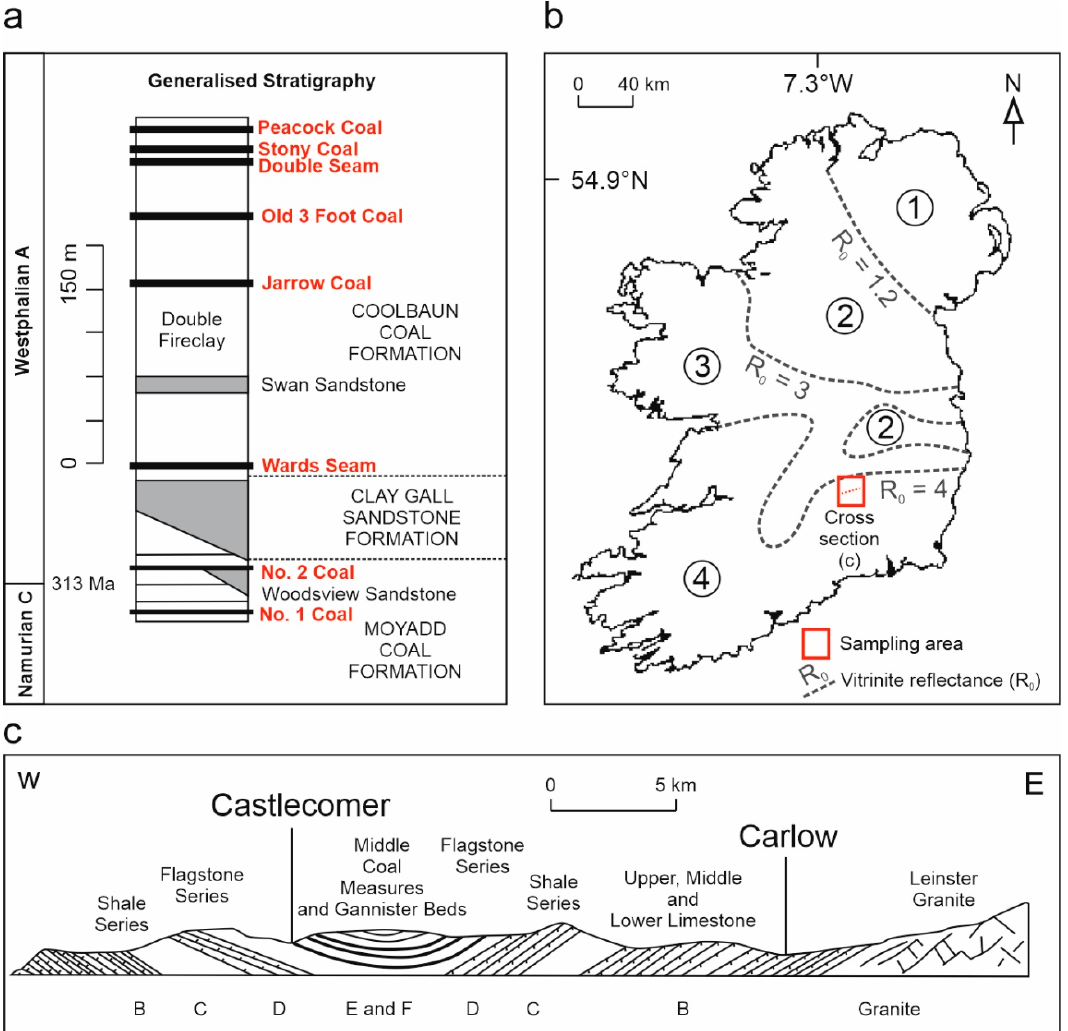
Figure 3. Regional geological setting of the Castlecomer Plateau study area in the Leinster Coalfield [35,36,38,39]. ( a ) Generalised stratigraphic section of the Castlecomer Plateau [38], including worked coal seams in the area (bold red text). ( b ) Map of Ireland showing coal sample study area, and division into zones 1–4 of increasing thermal maturity, delimited by vitrinite reflectance (R 0 ) values in Carboniferous rocks (simplified from [36]). ( c ) Section across the Leinster Coalfield, with Stages B–F classification of the series [39].